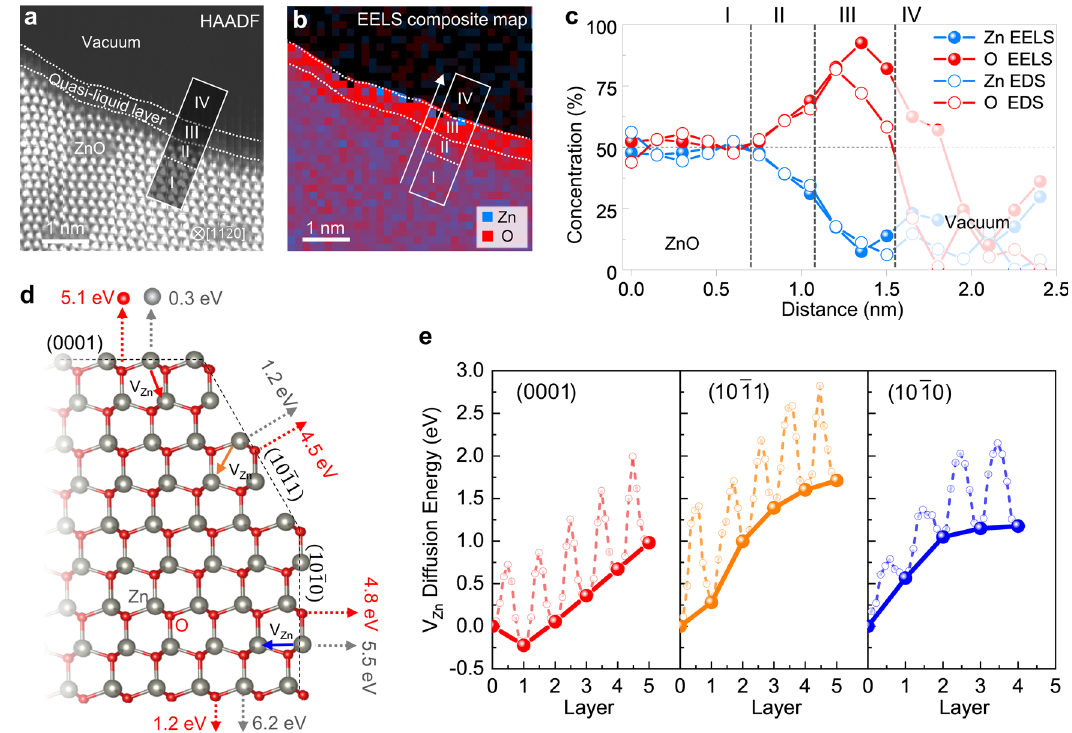
Fig. 3 | Zn-de fi cient quasi-liquidlayeron theZnO (0001) polarsurface.a STEM- HAADF image showing the (0001) surface covered by quasi-liquid layer at 300°C. b , Composite image constructed by selecting EELS Zn-L 2,3 and O-K edges. The regionmarkedbyI,II,IIIandIVindicatesthebulkZnO,subsurfaceZn 1- x O,thequasi- liquidlayerandvacuum,respectively. c Averagedcompositionpro fi lesofZnandO from the white lined box in a and b obtained by quanti fi cation of EELS data (solid symbols). The composition pro fi les obtained by quanti fi cation STEM EDS data by usingZn-K α andO-K α peaksareincluded(opensymbols).Formoredetails,referto Supplementary Fig. 7 and Supplementary Note 2. Both EELS and EDS results con- sistently show that the quasi-liquid layer (region III) and subsurface (region II) are